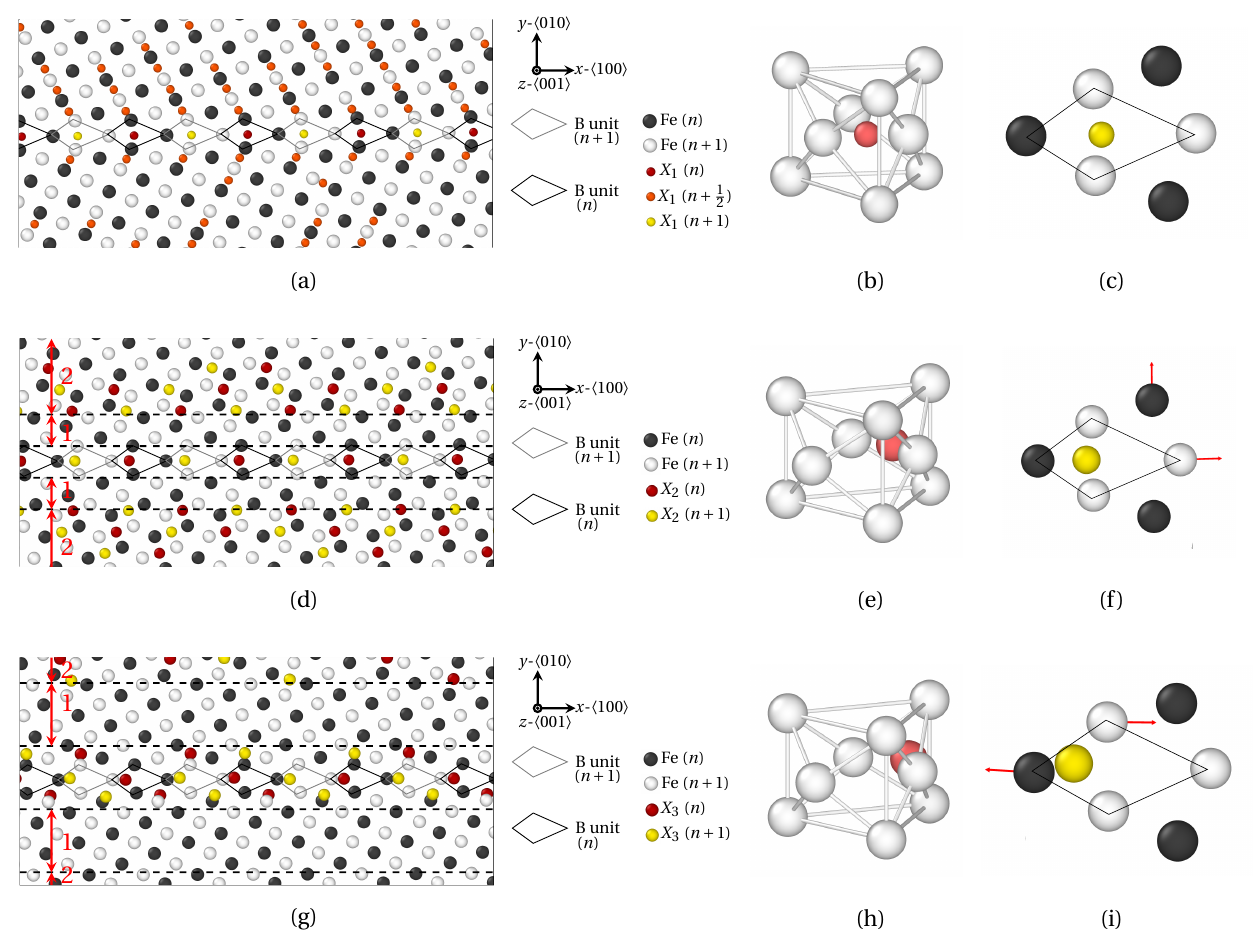
Figure 7. Segregation of solute X 1 ( a – c ) X 2 ( d – f ) and X 3 ( g – i ) atoms at Σ 5 ( 310 ) ( θ = 36.87 ◦ ) as provided by QA simulations ( t = 400). B structural units are materialized by black ( n plane) and gray ( n + 1 plane) lines. ( a , d , g ) Fe and X atoms positions. ( b , e , h ) Fe 9 X clusters. ( c , f , i ) Variation of X solute atom position within B unit, or equivalently Fe 9 X cluster. The depleted (over-compressed) and segregated (less compressed) areas are delineated by dashed black lines, and referred to as zones 1 and 2 in ( a , d , g